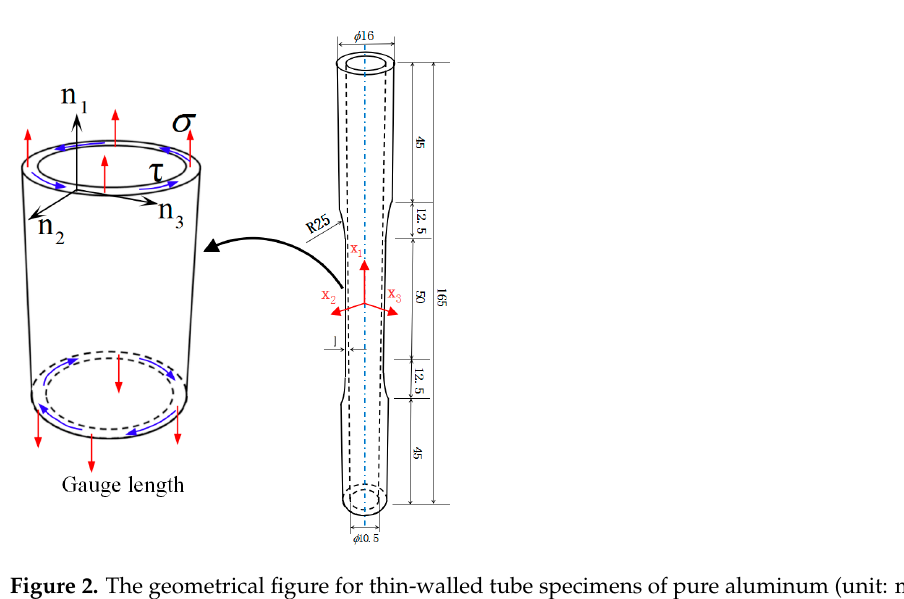
Figure 1. Cross-sectional microstructure of the specimen for pure aluminium observed by EBSD: ( a ) grain orientation map of pure aluminium; ( b ) the statistical distribution of the grain size; ( c ) the pole figure.